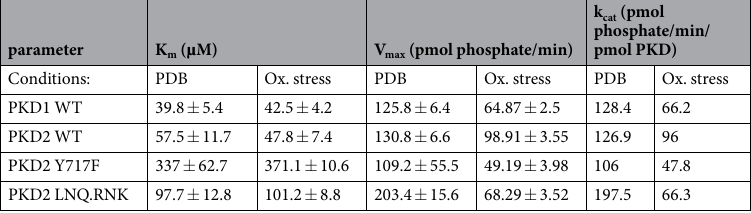
Table 1. Kinetic parameters for the different PKD preparations, values shown are mean ±